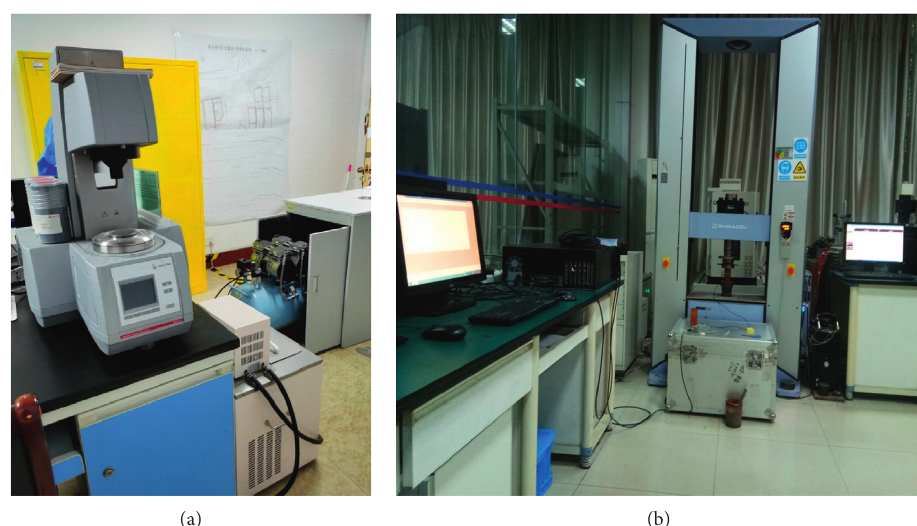
Figure 2: Experimental equipment. (a) Dynamic rheometer (Anton Paar) and (b) Shimadzu AG-X250 electronic universal testing machine, acoustic emission